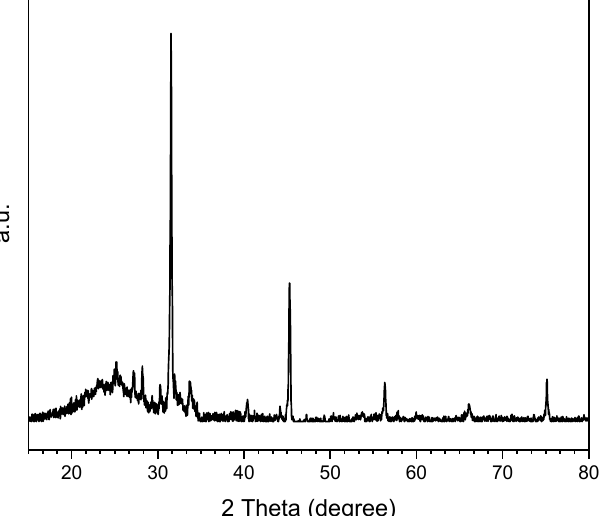
Figure 2. XRD of xanthan gum-cl-poly(acrylamide-co-alginic acid) hydrogel . The SEM images of that XG-cl-poly(AAm-co-AA) hydrogel were displayed in Figure 3. Figure 3a,b depicts the smooth surface of hydrogel whereas Figure 3c displays the highly folded surface with pores at higher magnification. Figure 3d represents the SEM image of XG-cl-poly(AAm-co-AA) hydrogel after adsorption of Cd(II) ions depicting rough surface which may be due to the addition of Cd(II) ions to the surface.